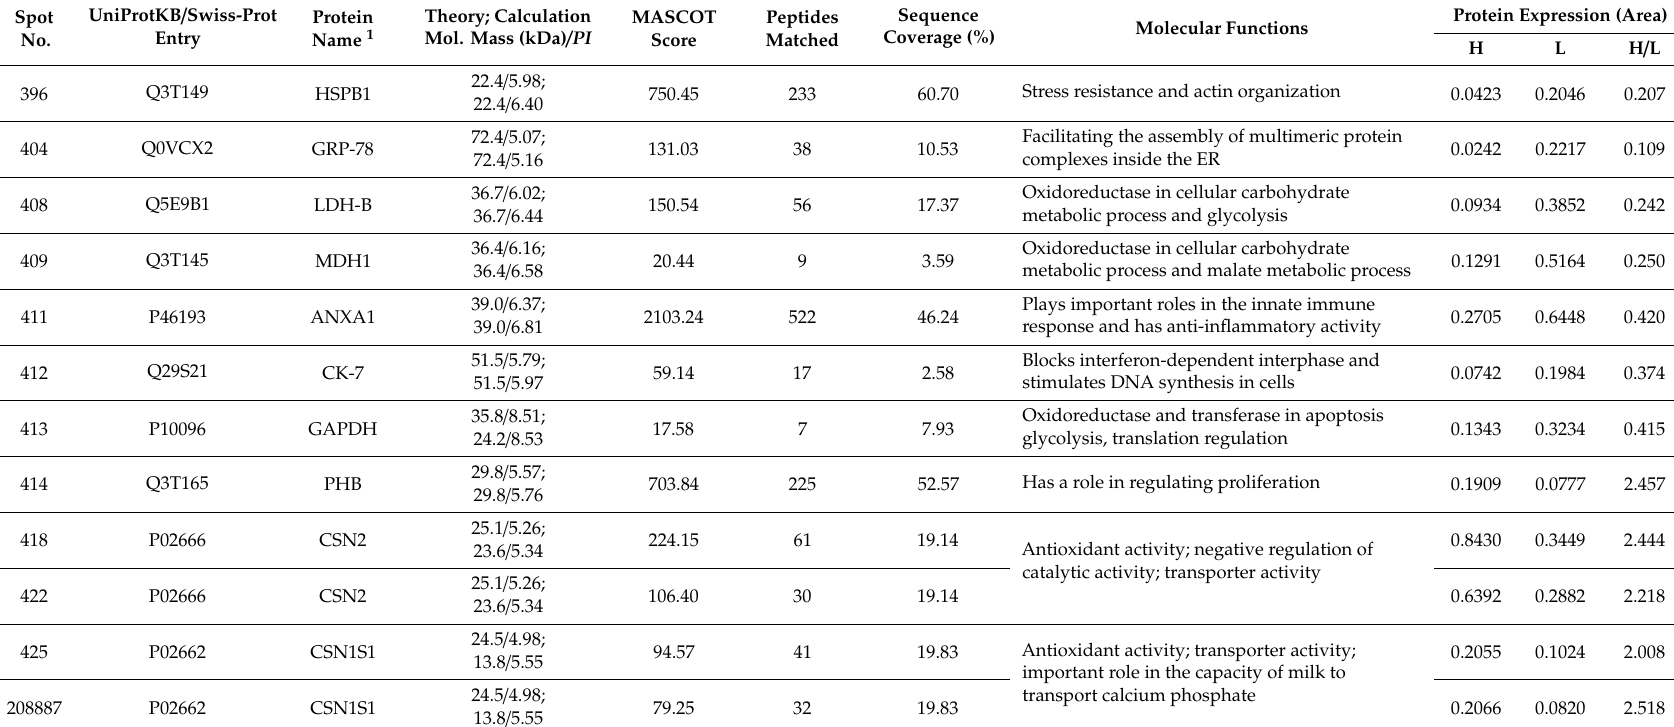
Table 2. List of di ff erently expressed proteins ( ≥ 2-fold or ≤ 0.5-fold) in isolated MECs. Spot